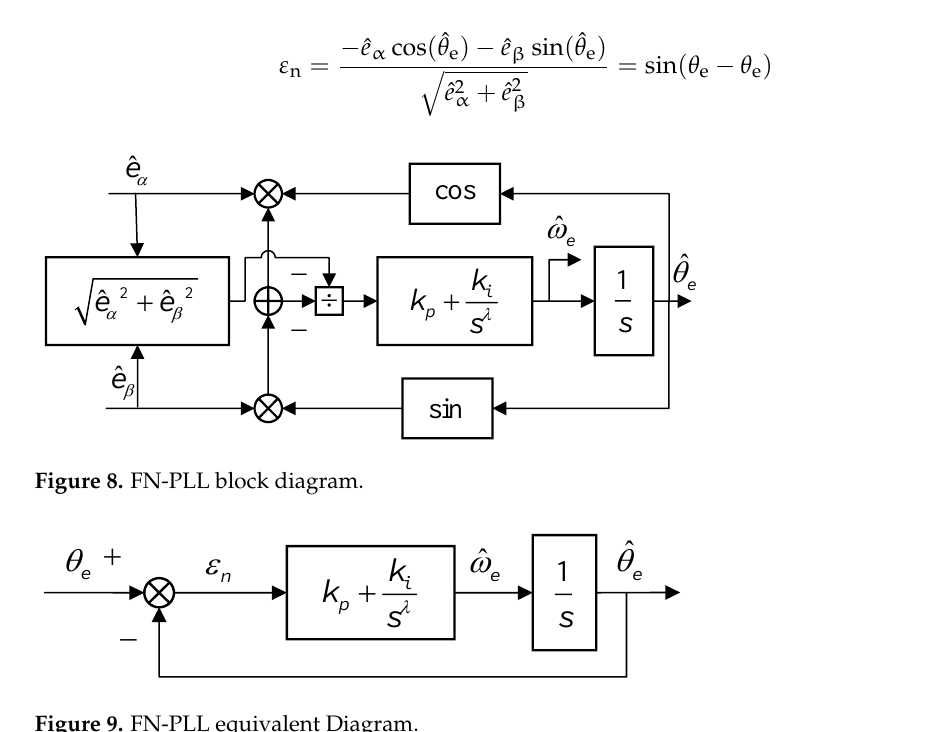
Figure 9. FN-PLL equivalent Diagram.